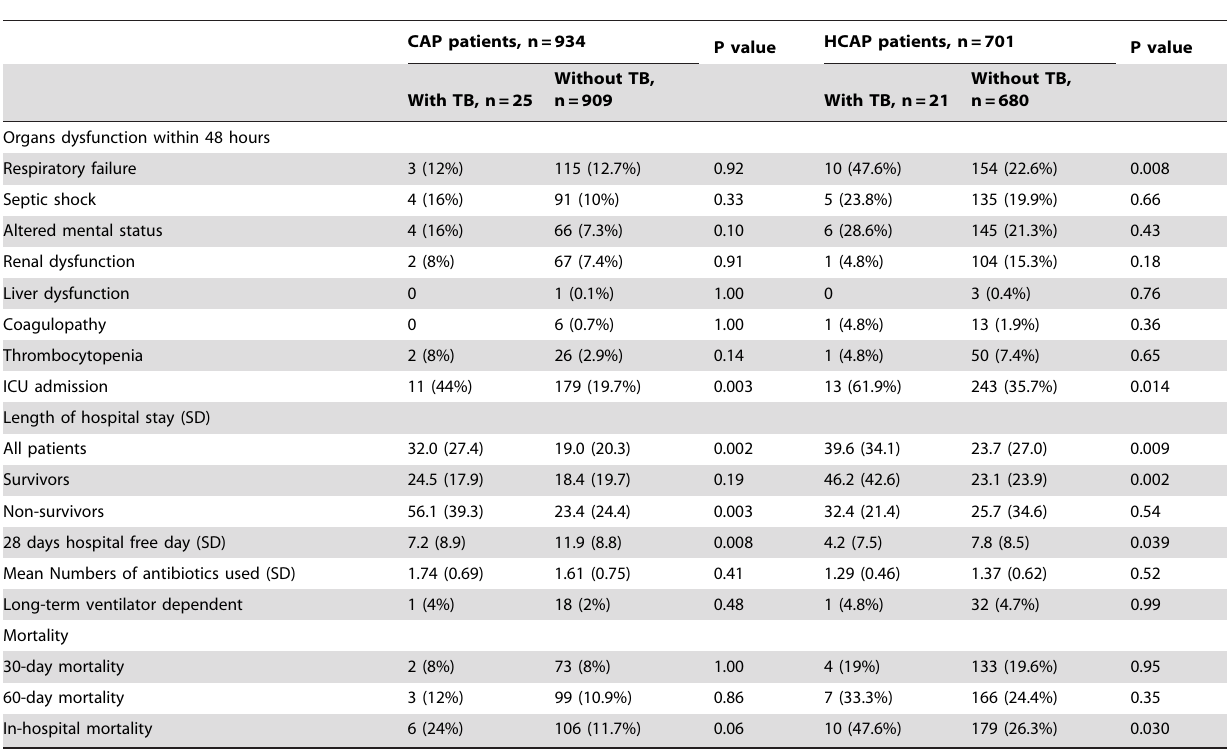
Table 5. Impact of concomitant tuberculosis in treatment outcome of HCAP and CAP patients a